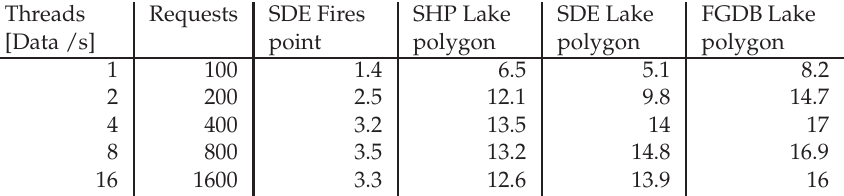
Table 6: WFS Geoserver tests results.